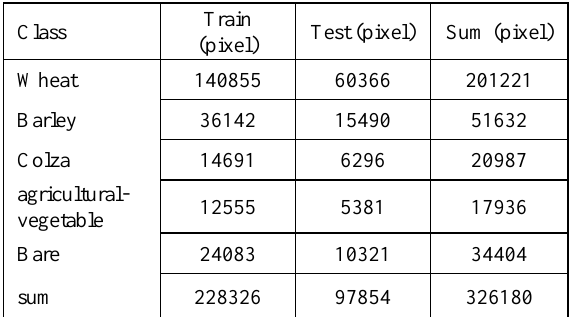
Table 1 . The number of training and test pixels collected for each class using in situ data.